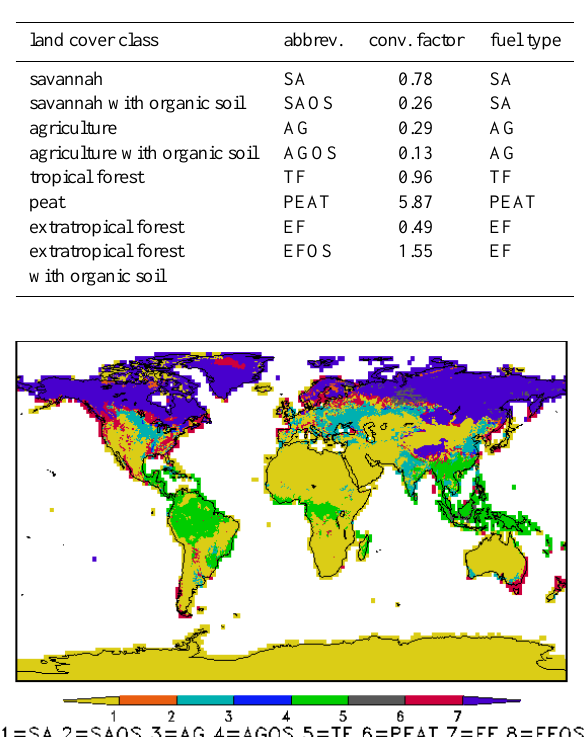
Fig. 3. Land cover class map based on dominant fire type in GFEDv3.1 and organic soil and peat maps. Gaps in land areas have been filled. Equidistant cylindrical projection, 0.5 ◦